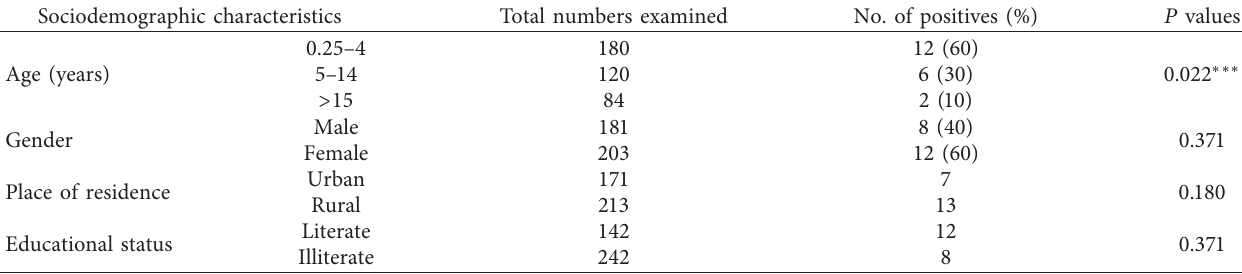
Table 1: Prevalence of Salmonella spp. and sociodemographic characteristics of the study participants ( n �